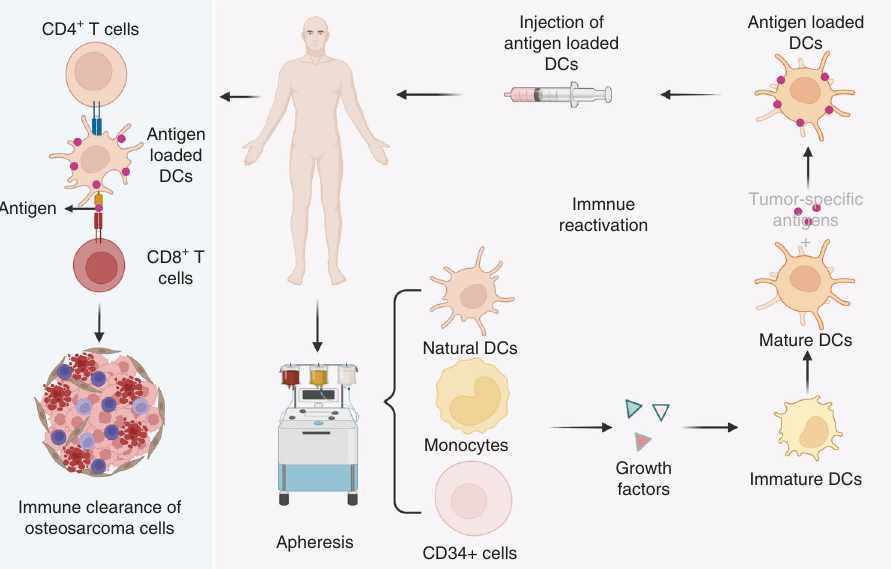
Fig. 6 The main process used to generate ex vivo DC vaccines. Progenitor cells are extracted from patients via dialysis, induced to transition into mature DCs, and then loaded with tumor antigens for administration to patients. Tumor antigen-speci fi c T lymphocytes are activated by injected antigen-loaded DCs to exert an antitumor